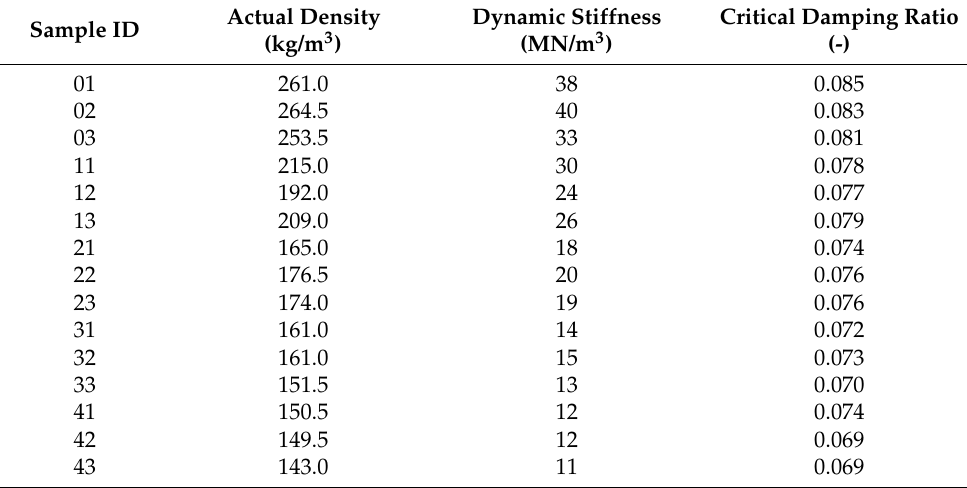
Table 4. Results of measurement of dynamic stiffness and critical damping ratio for tested samples of rebound polyurethane foam.